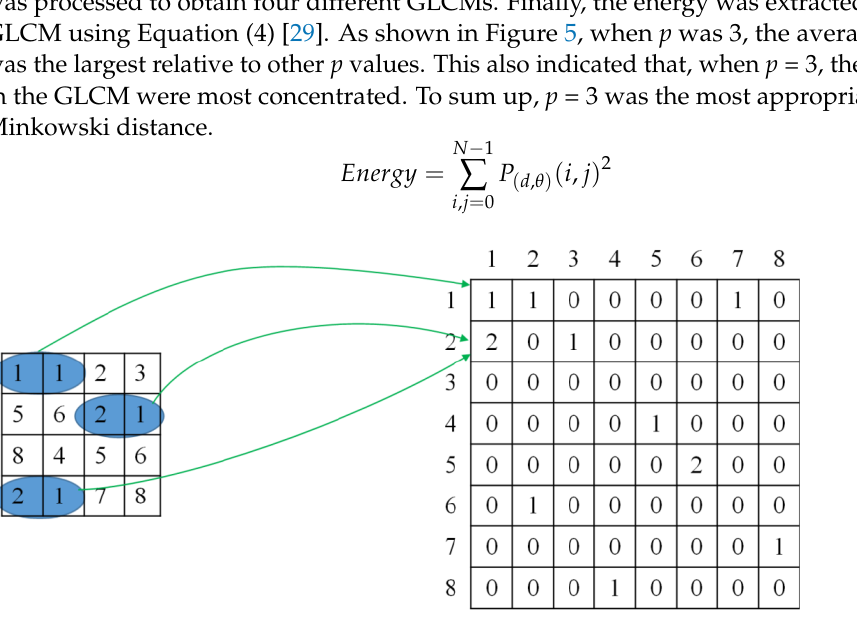
Figure 4. Example of a gray level co-occurrence matrix.